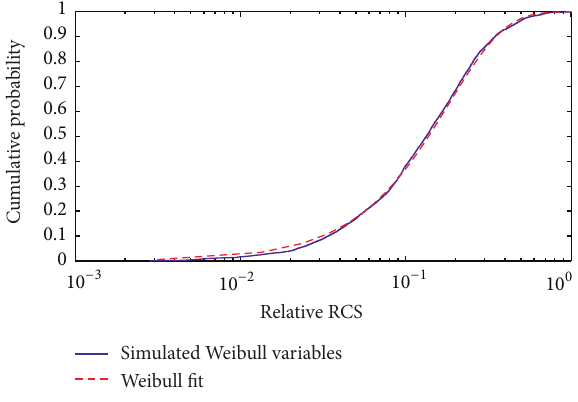
Figure 10: Cumulative distribution of the simulated RCS of a Weibull target in frequency